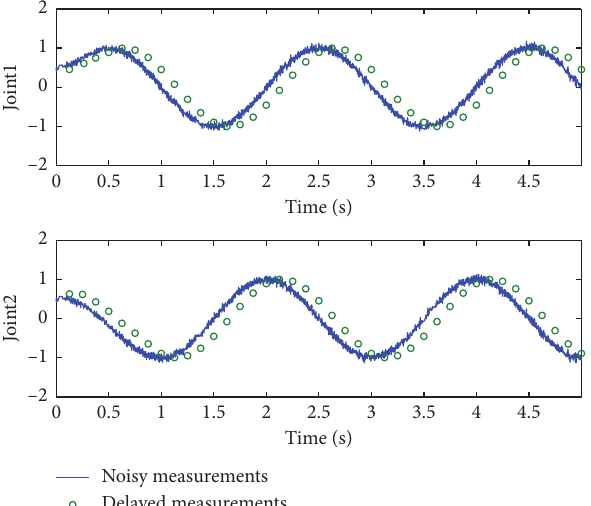
Figure 6: Comparative control performances of joint1 between the proposed method and SMC.